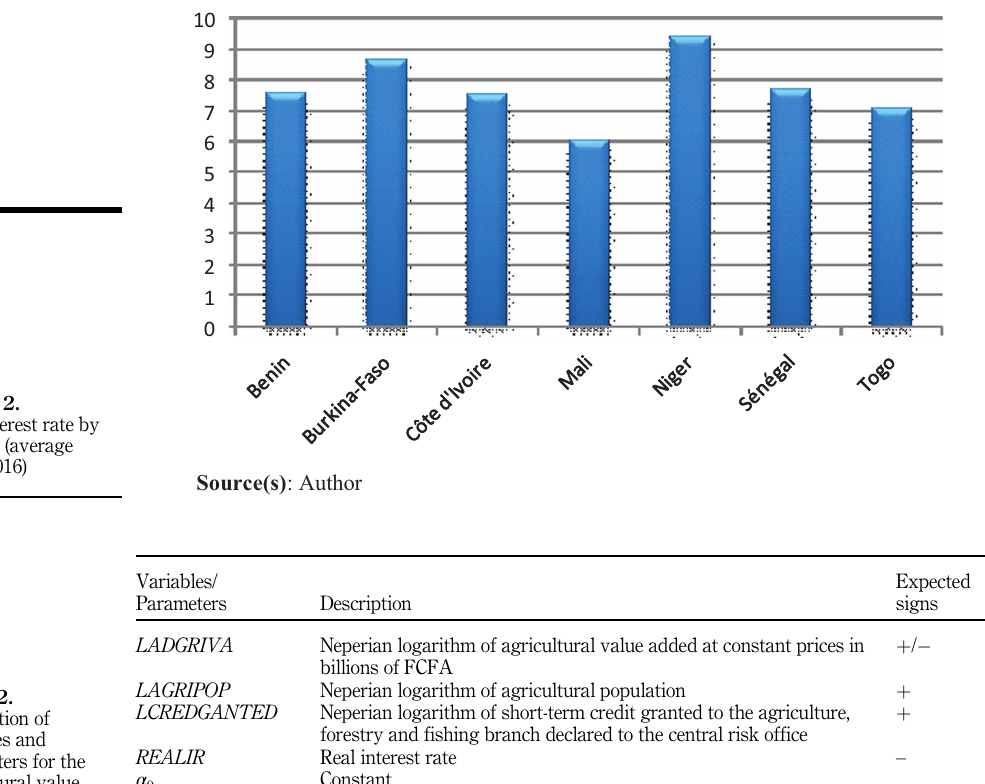
Table 2. Description of variables and parameters for the agricultural value added